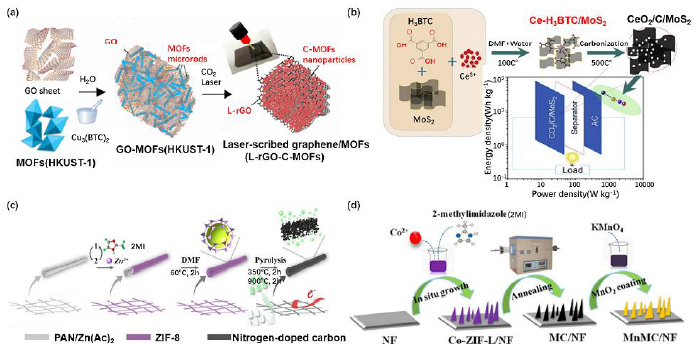
Figure 4. The schematic diagram of the preparation approach of ( a ) L-rGO-C-MOF [73], ( b ) CeO 2 /C/MoS 2 (derived from Ce-BTC) [74], ( c ) ZIF-8-derived NCT [76] and ( d ) ZIF-derived MnMC on NF [77]. Reproduced with permission from References [73,74,76,77]. Elsevier,